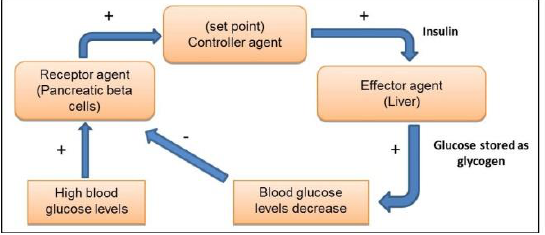
Figure 2. Negative feedback control mechanism of hormonal regulation of blood glucose levels Receptor agent senses changes in plasma glucose levels and sends its information to controller agent. We represent the receptor agent as pancreas. Controller agent has a set point. If blood glucose levels above the set point, controller agent sends an